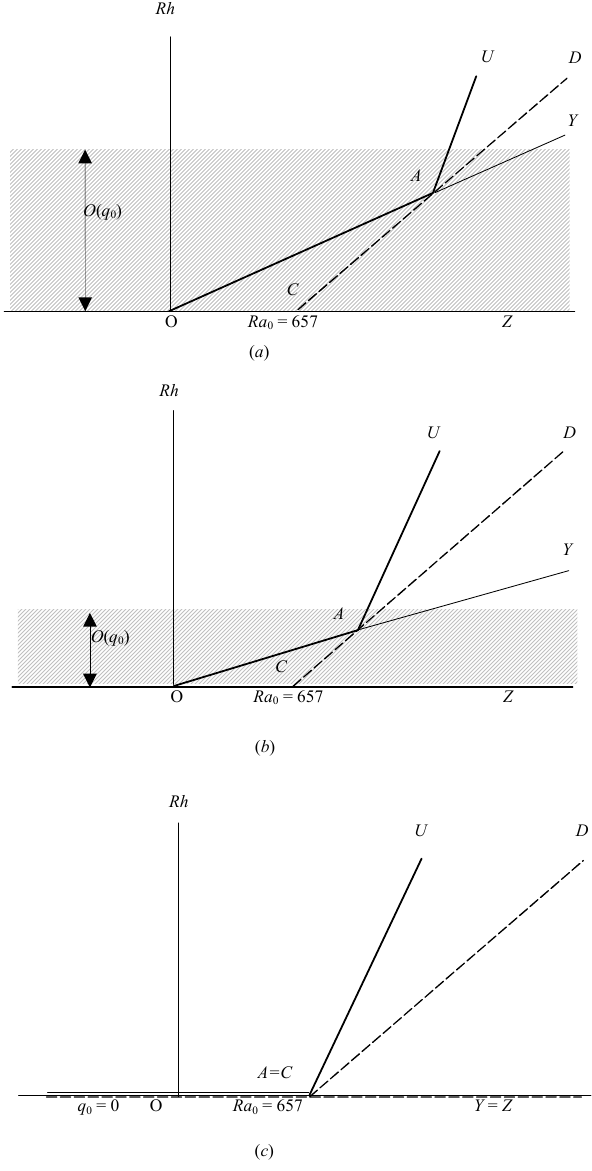
Fig. 5. Successive positions of the oscillatory instability threshold for decreasing q 0 . When q 0 → 0 (and, hence, τ → +∞ ), the thickness of the realistic region decreases so that, for vanishing q 0 , the oscillatory instability region progressively goes to the stationary instability region of the classical Rayleigh-B´enard convection (in order to exhibit the different regions more explicitly, the scales are not respected on the